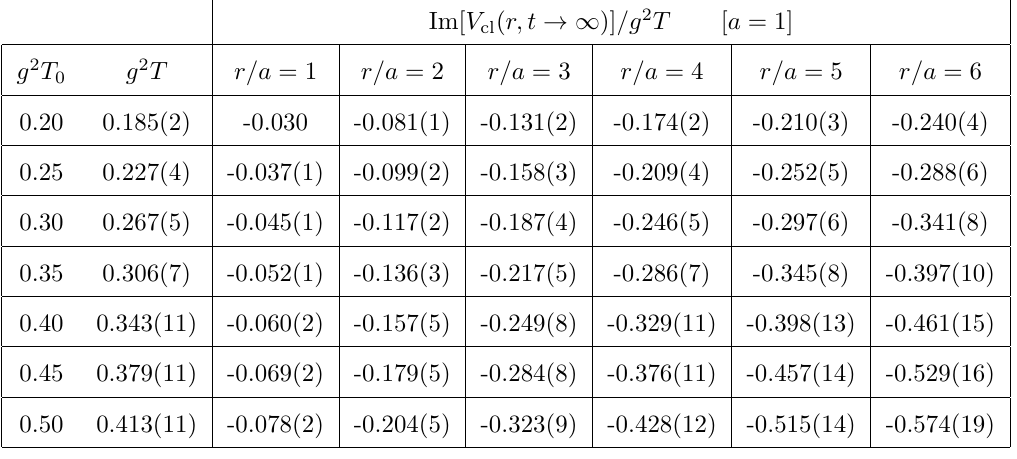
Table 1 . Values of Im[ V cl ( r )] /g 2 T for different T 0 extracted from lattice simulations with a = 1 , N = 64 and 224 configurations.